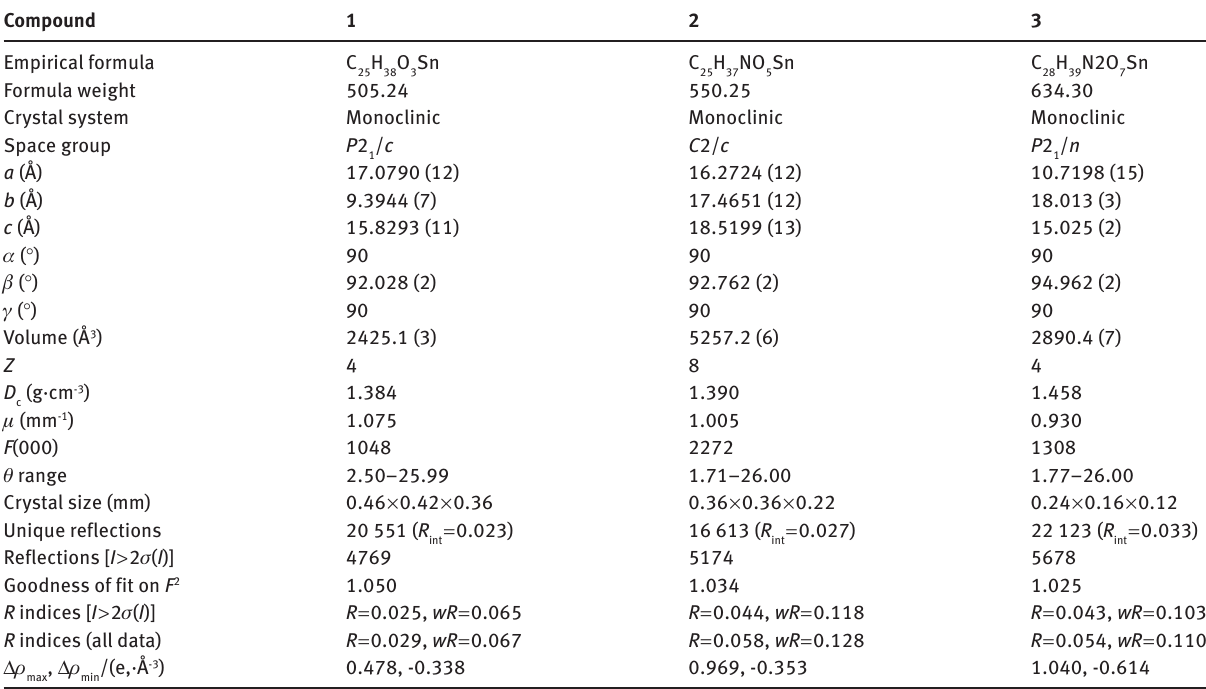
Table 4: Crystallographic data and structure refinement for 1–3